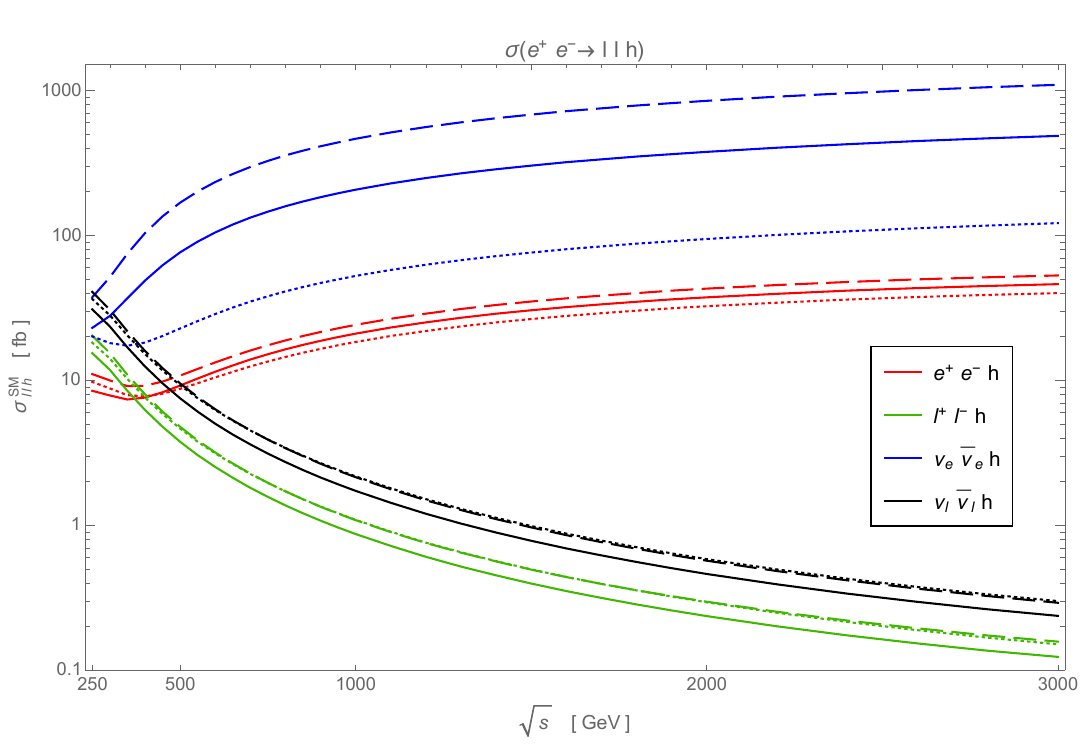
Figure 3. Interplay between beam polarisation P , P and cross-sections, σ SM , in fb, as functions e + e − ‘‘h √ of the centre-of-mass energy, s , in GeV, for single-Higgs production in association with a pair of leptons, where in the legend, ‘ = { µ, τ } , for unpolarised beams (solid), P , P = +50% , − 50% e + e − (dashed), and P , P = − 50% , +50% (dotted). Note that both e + e − h and ν e ν e h final states e + e − consist of Zh-ZBF interference for the former, and Zh-WBF for the latter. The chosen beam polarisations are meant for illustration purposes and do not necessarily correspond to the projected configuration of future